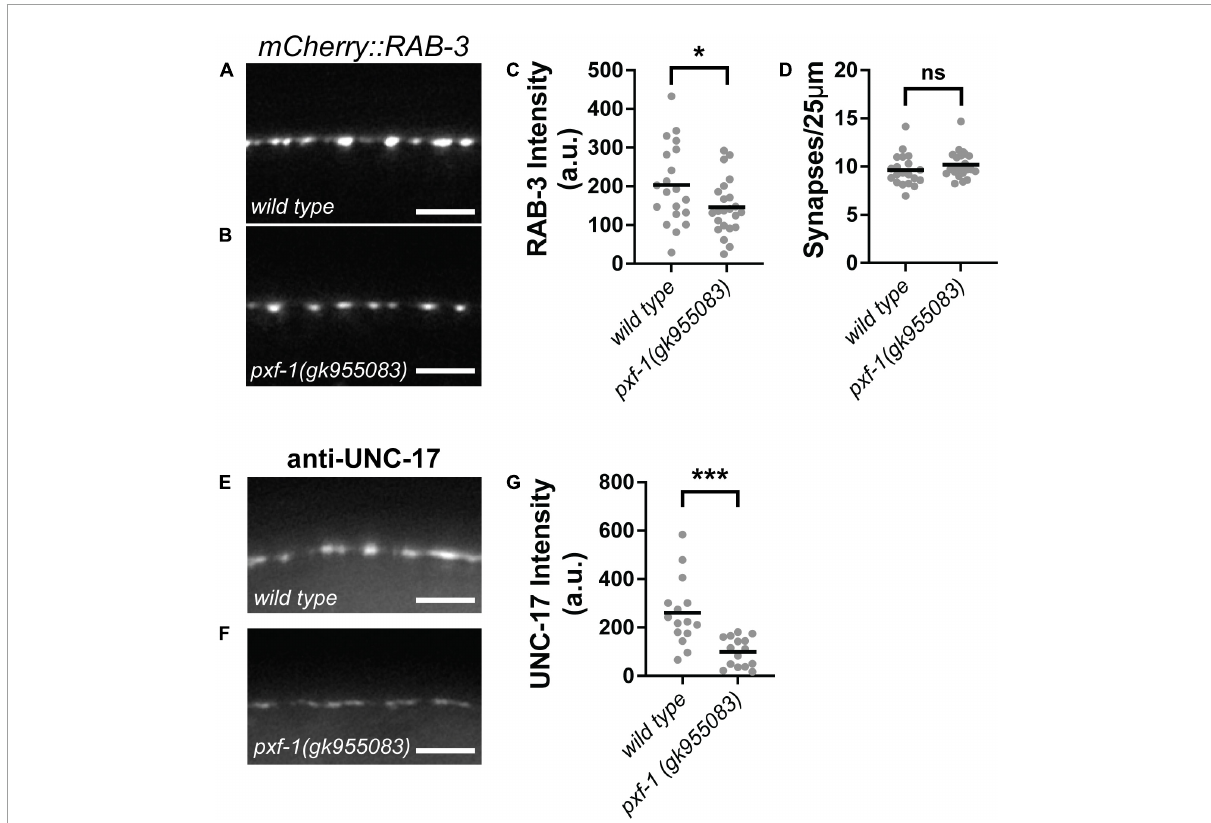
FIGURE3 PXF-1 increases synaptic vesicle abundance in cholinergic motor neurons. (A,B) Representative images of mCherry:RAB-3 labeled acetylcholine synapses in dorsal cord of (A) wild type and (B) pxf-1(gk955083) animals. Scale bars are 5 µ m. (C) Quantification of fluorescence intensity in arbitrary units, a.u. (D) Quantification of synaptic density. Gray dots represent individual animals, black bars indicate means. n = 20–23 animals. * p < 0.05; ns, not significant. (E,F) Representative images of dorsal cord stained for UNC-17 in (E) wild type and (F) pxf-1(gk955083) animals. Scale bars are 5 µ m. (G) Quantification of fluorescence intensity. Gray dots represent individual animals, black bars indicate means. n = 15–16 animals. *** p <